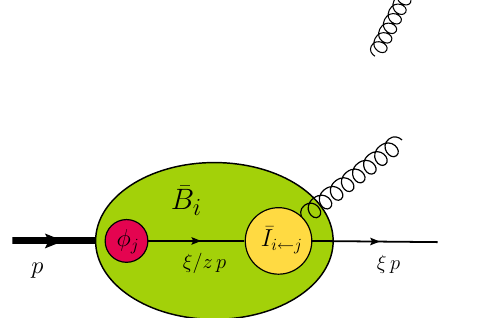
Fig. 1 Structure and kinematics of the factorization theorem for electroweak boson production at low transverse momentum. The wavy lines denote the bosons in the final state. We can also include their leptonic decays in our framework